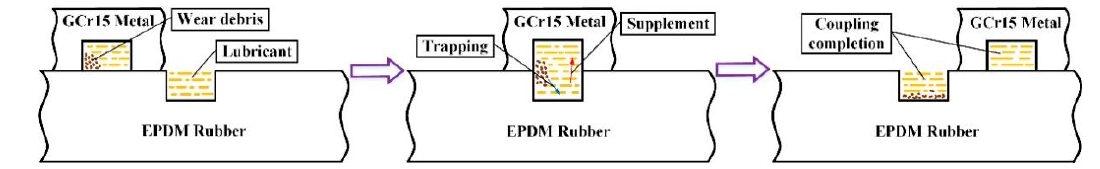
12 of 15 Figure 13. SEM images and EDS analysis of GCr15 metal surface under optimal coupling texture parameters: ( a ) SEM image of the sample surface with optimal coupling texture parameters; ( b ) corresponding EDS analysis. Figure 14. SEM images and EDS analysis of GCr15 metal surface under the worst coupling texture parameters: ( a ) SEM image of the sample surface with the worst coupling texture parameters; ( b ) corresponding EDS analysis. 3.6. Mechanism of Texture Coupling The schematic diagram of the coupling texture mechanism (at the symmetry plane) is shown in Figure 15. Before the GCr15 metal dimple texture reached the EPDM rubber dimple texture, the lubricating oil stored in the EPDM rubber dimple texture formed an oil film on the untextured area. With the relative sliding of the friction pair, the GCr15 metal dimples collected the wear debris generated by part of the wear, which led to the weakening of the dynamic pressure effect in the dimple texture and a decrease in oil pressure. When the GCr15 metal dimple texture passed through the EPDM rubber dimple texture, the normal load extruded the lubricating oil from the EPDM rubber dimple, filling in the GCr15 metal dimple texture and replenishing the oil film. At the same time, the inside of the GCr15 metal dimple was pushed out. Part of the collected wear debris was flushed into the underlying rubber dimple texture, preventing the wear debris from continuing to damage the surface as the metal pin moved. When the GCr15 metal dimple texture left the EPDM rubber dimple texture, due to the lubricating oil supplemented by the EPDM rubber dimple texture, the lubricating oil in the GCr15 metal dimple texture enhanced the dynamic pressure effect and increased the maximum oil film bearing capacity. The reduction of wear debris in the metal pit texture also relatively enhanced its ability to capture new wear debris. Under the coupling effect of the metal dimple texture and the rubber dimple texture, the dynamic pressure effect inside the coupling texture